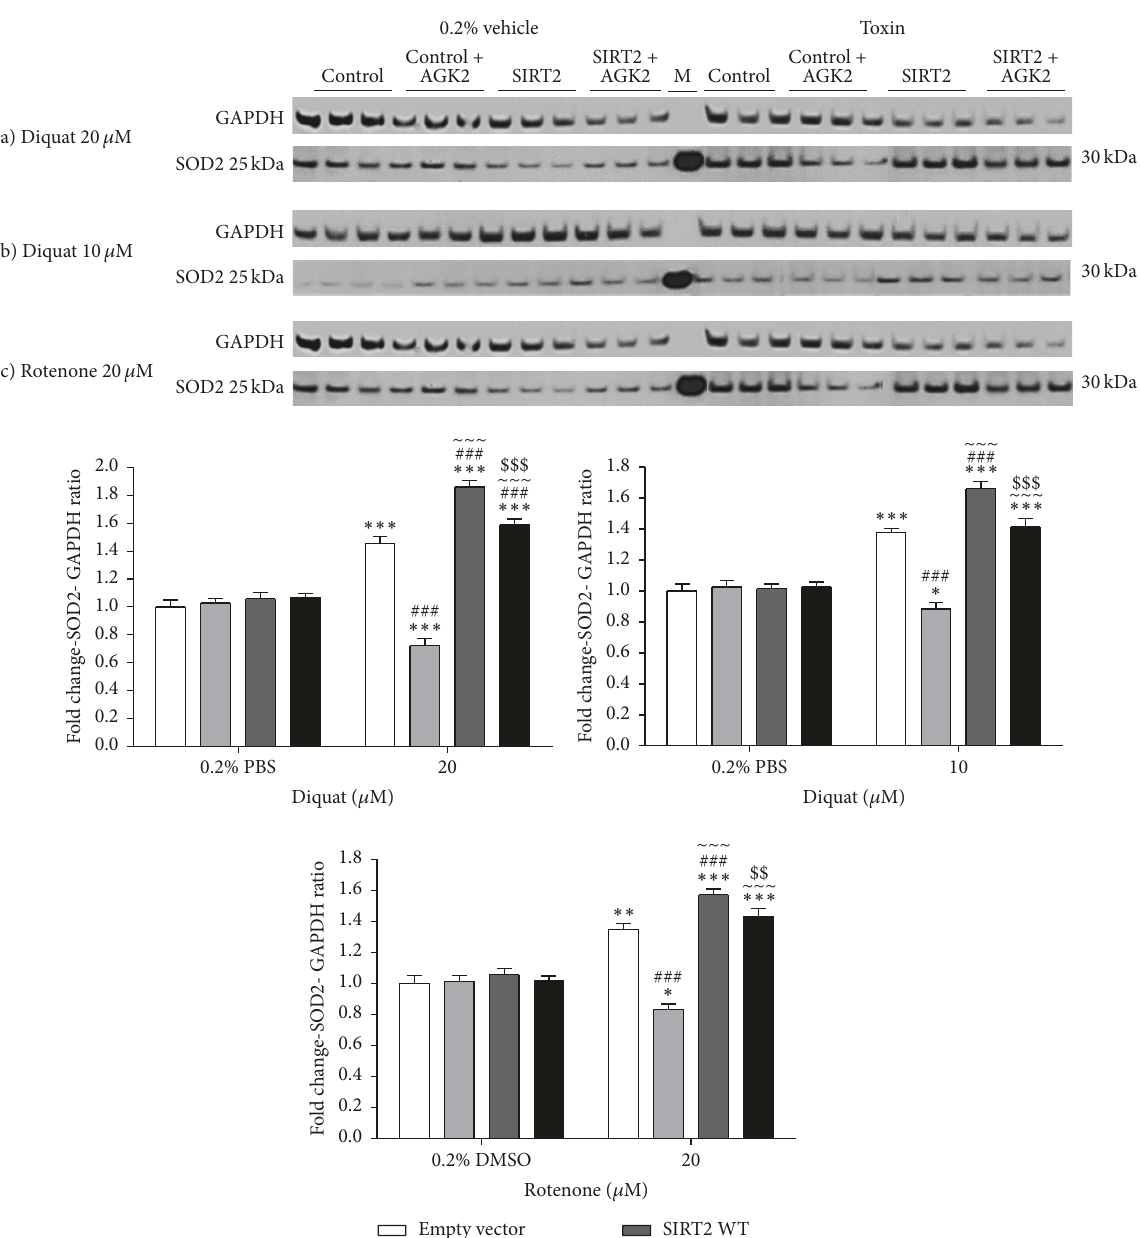
Figure 2: Expression of SOD2 was measured in toxin treated SH-SY5Y cells. SIRT2 was overexpressed in SH-SY5Y cells and control cells were transfected with empty vector following which one set of cells was treated with toxin alone and another with SIRT2 inhibitor AGK2 and toxin. Cells were harvested and the samples were probed for SOD2 expression. Data presented as fold-untreated (0.2% vehicle) ( ± SD) from three independent assays ( 𝑛 = 3 ). ∗∗∗ 𝑝 < 0.001 , ∗∗ 𝑝 < 0.01 , and ∗ 𝑝 < 0.05 when compared to 0.2% vehicle, one-way ANOVA (Bonferroni corrected), ### 𝑝 < 0.001 when compared to control cells, ∼∼∼ 𝑝 < 0.001 when compared to control + AGK2 treatment, and $$$ 𝑝 < 0.001 and $$ 𝑝 < 0.01 when compared to SIRT2, two-way ANOVA (Bonferroni corrected). M indicates molecular weight marker